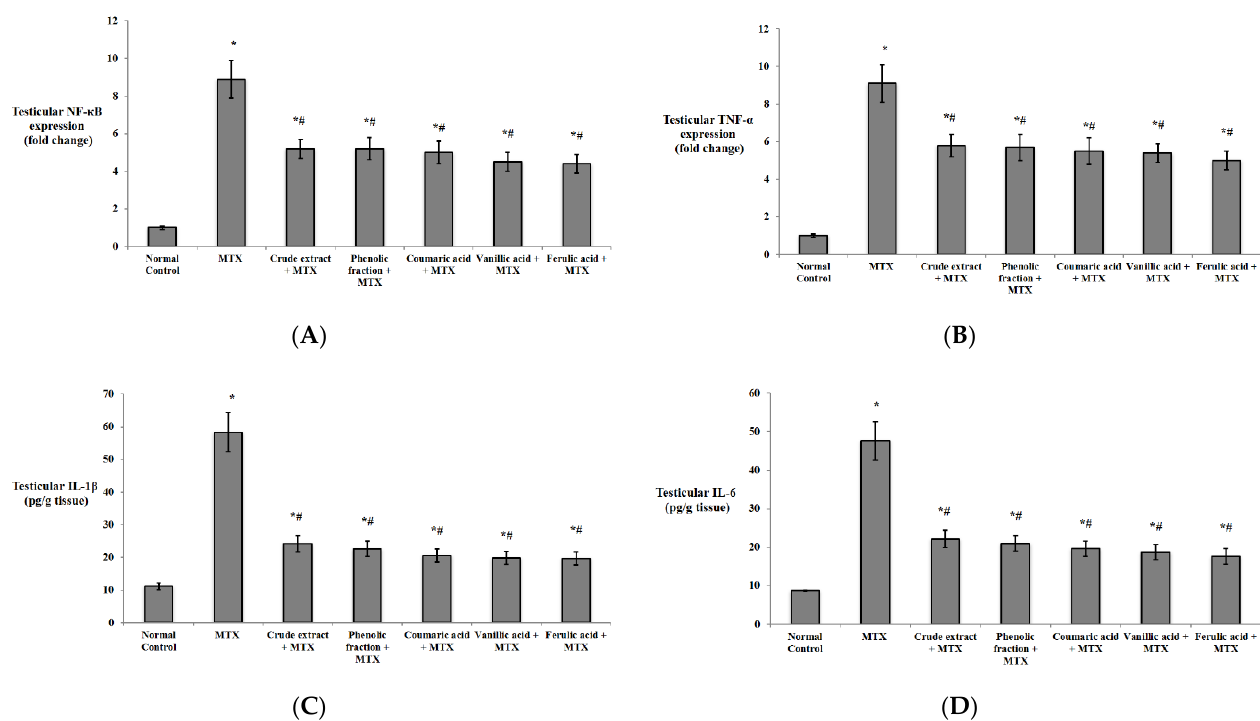
Figure 7. Effects of C. endivia L. crude extract, phenolic fraction, and its isolated compounds (coumaric, vanillic, and ferulic acids) on the testicular inflammatory biomarkers in the experimental mice. ( A ) NF- κ B expression, ( B ) TNF- α expression, ( C ) IL-1 β levels, and ( D ) IL-6 levels. Data are expressed as the mean ± SD. Data were analyzed using one-way ANOVA then Bonferroni’s post hoc test. * Significant against normal control group, # significant against MTX control group. Values were considered different significantly at p < 0.05. NF- κ B: nuclear factor-kappa B, TNF- α : tumor